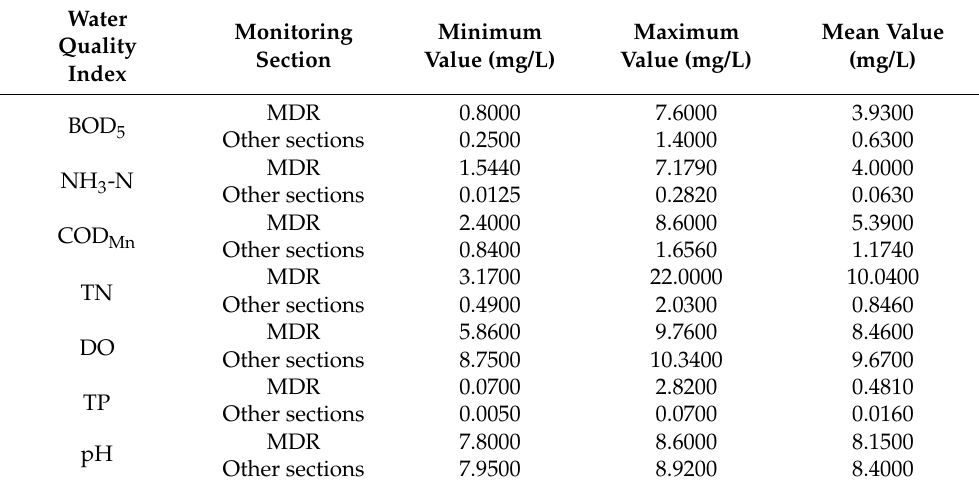
Table 5. Monitoring data of various indicators for Madian River and all other sections.